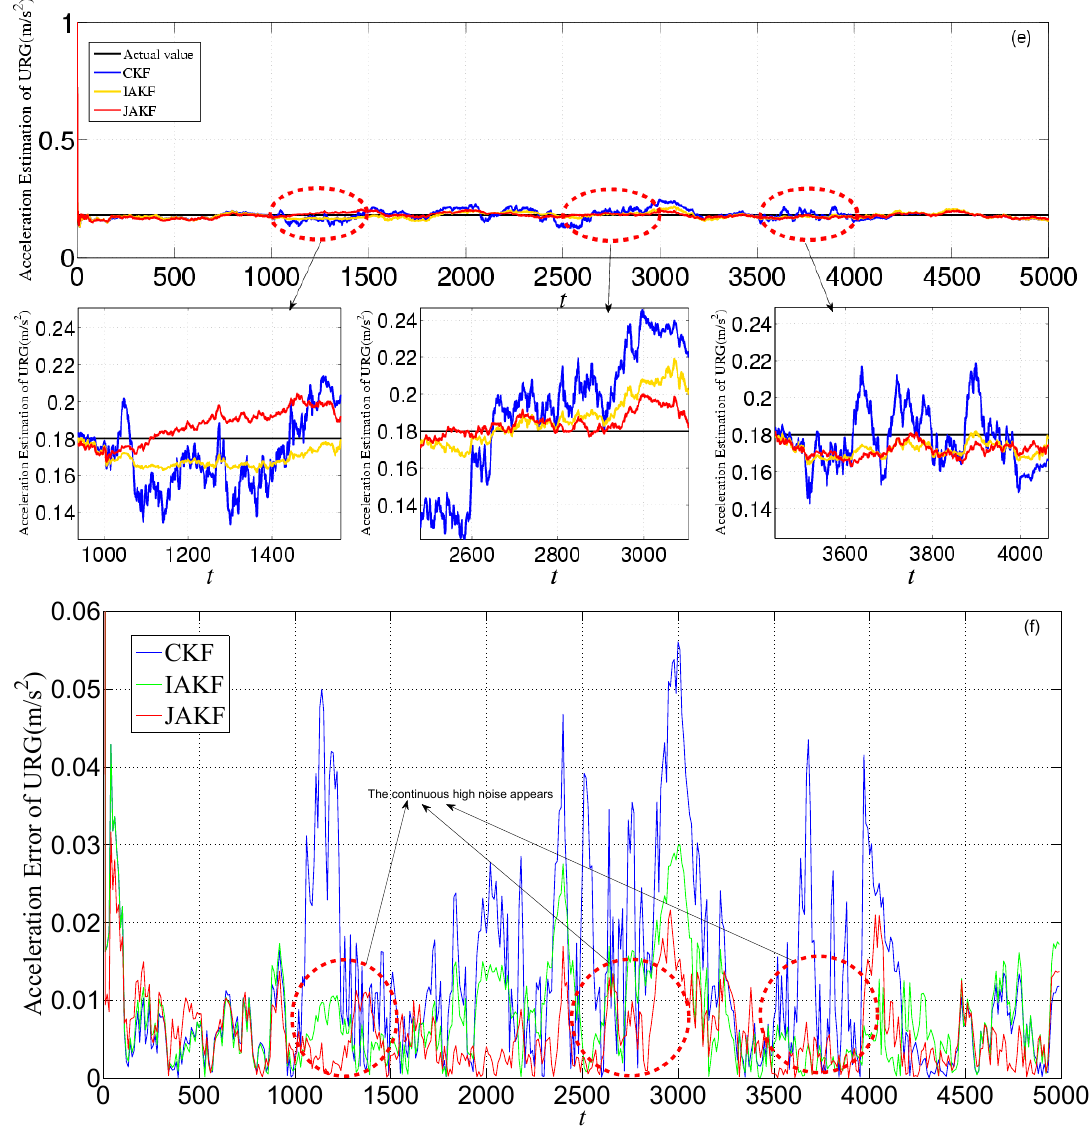
Figure 10. Estimation and error comparison of URG in the first experiment: ( a ) Displacement estimation of URG; ( b ) Displacement error of URG; ( c ) Velocity estimation of URG; ( d ) Velocity error of URG; ( e ) Acceleration estimation of URG; ( f ) Acceleration error of URG.